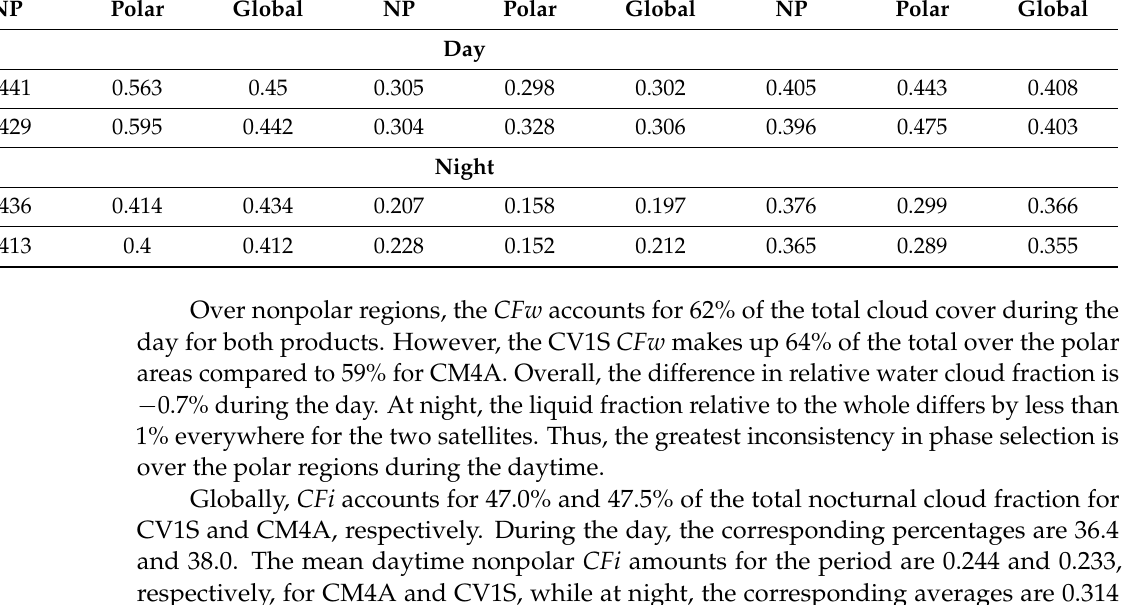
Figure 7 maps the 2013 mean water cloud effective heights for both CM4A and